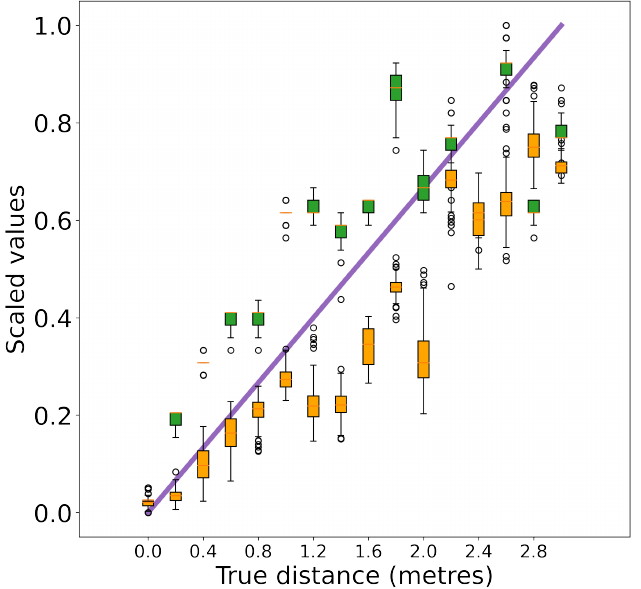
Figure 11. The comparison of the WiFi RSS and RTT measurements as a function of the true distance in LOS scenario. The RSS (as shown in green color) and RTT (as shown in orange color) values were normalized. We observed that under LOS conditions, RSS measures were more resilient.